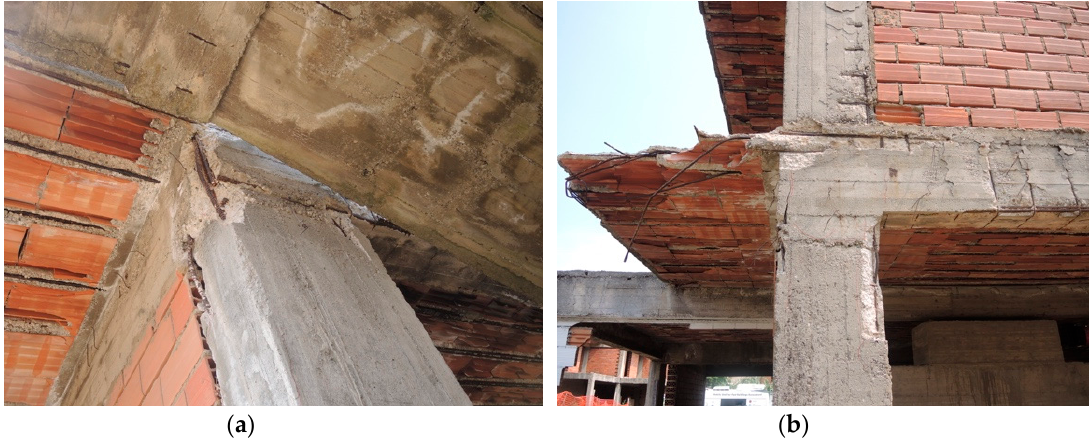
Figure 21. Run #9, 62.4 mm—1.69%: Joint damage at the top of column c14 ( a ) and c8 ( b ).